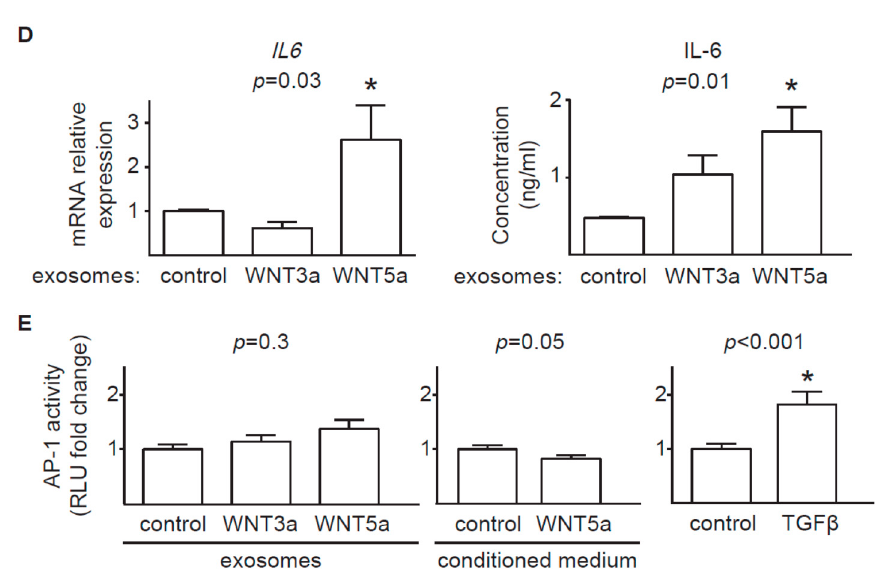
Figure 5. Activation of the noncanonical WNT pathway in cardiac fibroblasts. Human cardiac fibroblasts were stimulated with exosomes produced by L-WNT3a, L-WNT5a, or control L cells. Panels ( A – C ) illustrate representative immunoblots and the respective quantifications of pMEK1 to total MEK1 ( A , n = 3), pERK1/2 to total ERK1/2 ( B , n = 6), and pJNK to total JNK ( C , n = 4) 3 h after stimulation of cardiac fibroblasts with the respective exosomes. Graphs show means ± SEM, p values computed using the Kruskal–Wallis analysis followed by Dunn’s multiple comparison test. * p < 0.05 (post-hoc test vs. control). Panel ( D ) indicates IL6 gene expression ( n = 9, left) and IL-6 protein measured in supernatants ( n = 5, right) of cardiac fibroblasts treated with indicated exosomes for 24 h. Graphs show means ± SEM, p values computed using one-way ANOVA followed by Dunnett’s multiple comparisons test, * p < 0.05 (post-hoc test vs. control). Panel ( E ) shows quantification of AP-1 activity in AP-1-hCF reporter cardiac fibroblasts after treatment with the respective exosomes (left), conditioned medium (middle) or 10 ng/mL TGF- β for 18 h. Graphs show means ± SEM, n = 14, p values computed using one-way ANOVA followed by the Dunnett’s multiple comparisons test (for exosomes), * p < 0.05 (post-hoc test vs. control) or Student t -test.